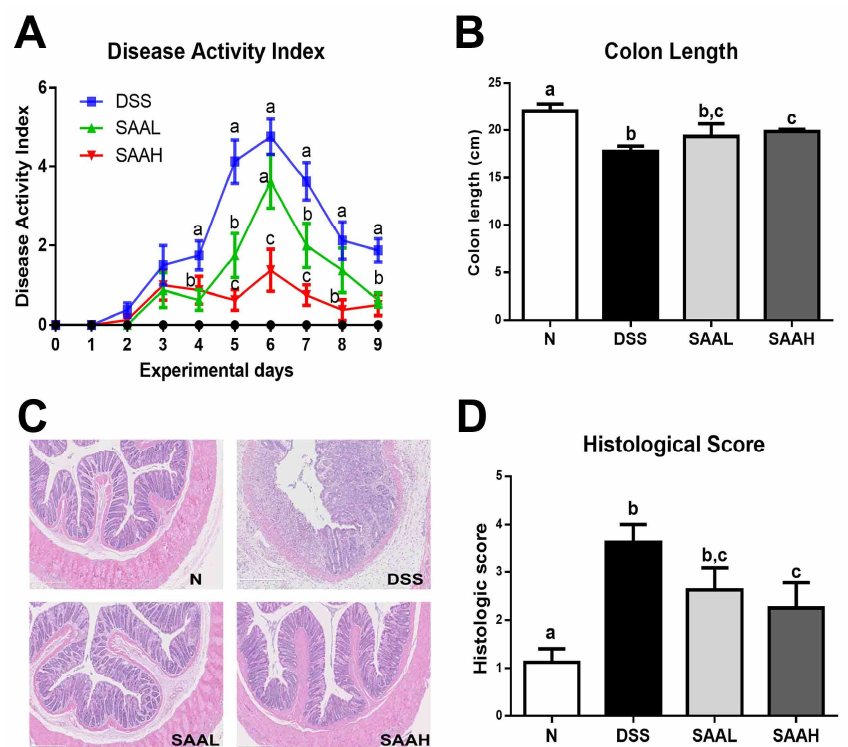
Figure 2. Salvianolic acid A ameliorated DSS-induced acute colitis symptoms in rats. The rats were administered DSS (4%) in drinking water for seven days. The SAA low-dosage group (SAAL, 4 mg/kg/day i.v.) and SAA high-dosage group (SAAH, 8 mg/kg/day i.v.) were tail vein-injected with SAA until the end of the experiment. ( A ) Disease activity index (DAI) values were recorded daily. ( B ) Colon length was recorded and compared among the normal control (N), DSS, SAA low-dosage group (SAAL), and SAA high-dosage group (SAAH). The data shown are the means ± SD, and means with different letters are significantly different ( p < 0.05); n = 8 rats per group in a single experiment. ( C ) Representative hematoxylin and eosin (H&E)-stained distal colon sections. ( D ) The histologic scores of rats. The data represent the mean ± SD of eight rats per group.